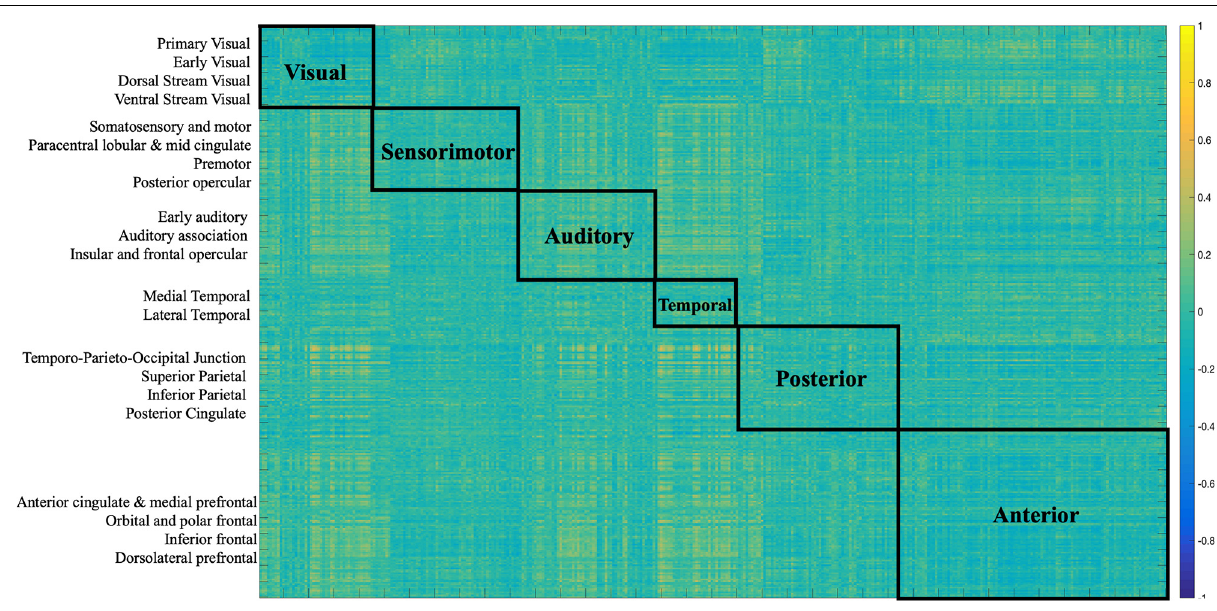
FIGURE 2 | Correlation matrix between SC and FC modalities. The first 180 regions pertain to the left hemisphere and the next 180 (i.e., 181–360) to the right hemisphere (i.e., homologs). Their full description can be found in Table 1 in Supplementary Neuroanatomical Results in Glasser et al. (2017). The color bar refers to the strength of the